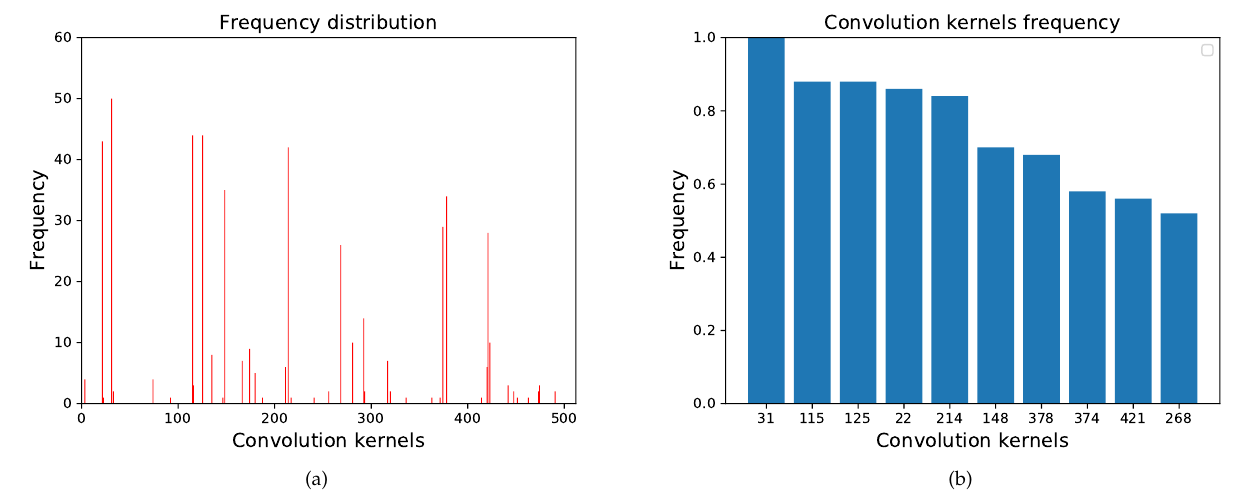
Figure 8. The frequency distribution of different radar targets. ( a ) The frequency distribution of 512 convolution kernels. ( b ) The frequency of clustered convolution kernels. Table 1. Activation intensity ranking of feature maps for different types of targets.